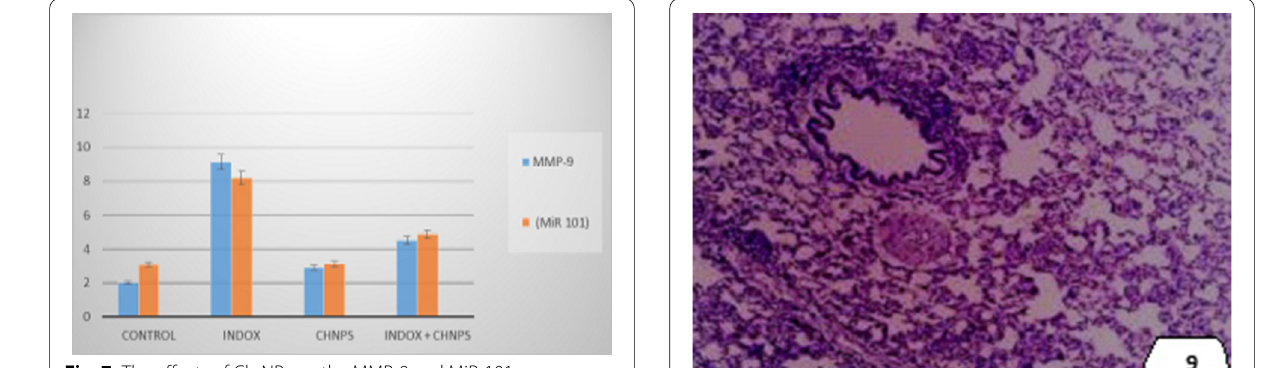
Fig. 7 The effects of Ch-NPs on the MMP-9 and MiR-101 gene expression levels in rats treated with INDOX